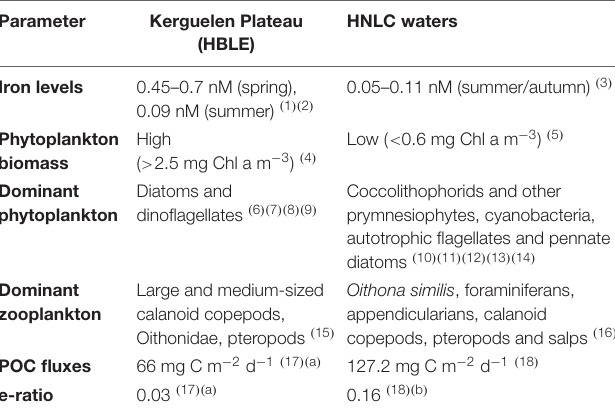
TABLE 1 | Comparison of environmental parameters and plankton groups between the HBLE Kerguelen Plateau and the HNLC waters south of